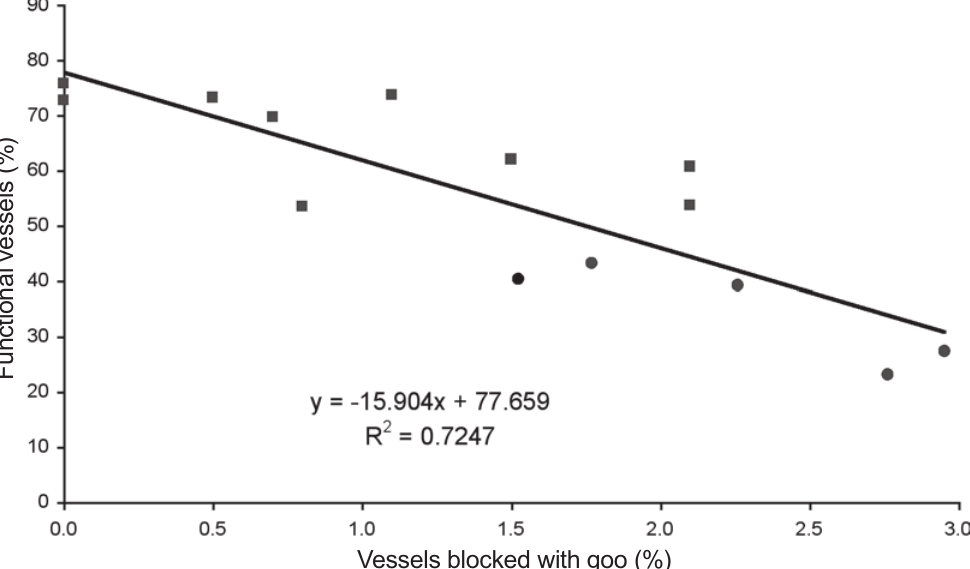
Vessels blocked with goo Fig. 2. Relationship between percentage of functional xylem and percentage of xylem blocked with black goo of Verdelho grapevines infected with P. chlamydospora . (cid:1) = 2002 data, (cid:2) = 2004 data.